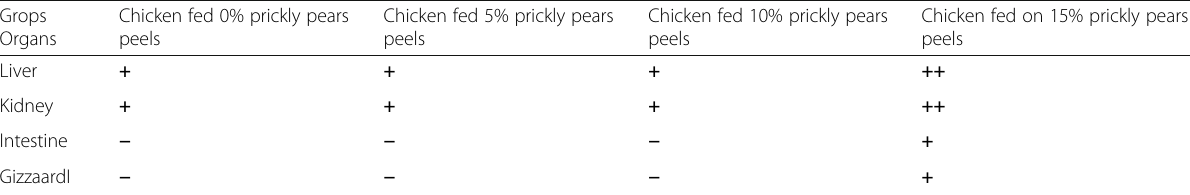
Table 8 Severity of the lesions of chicken fed different levels of prickly pears peels Grops